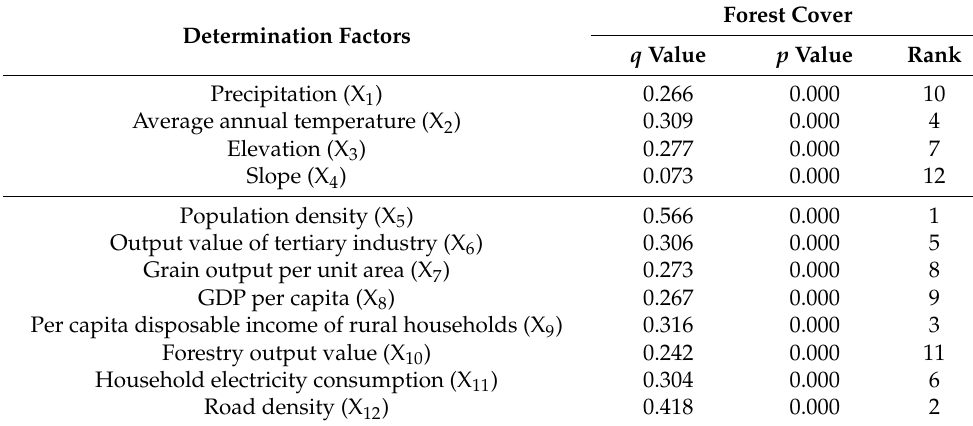
Table 4. Results of factor detector for the spatial distribution of forest cover in Fujian